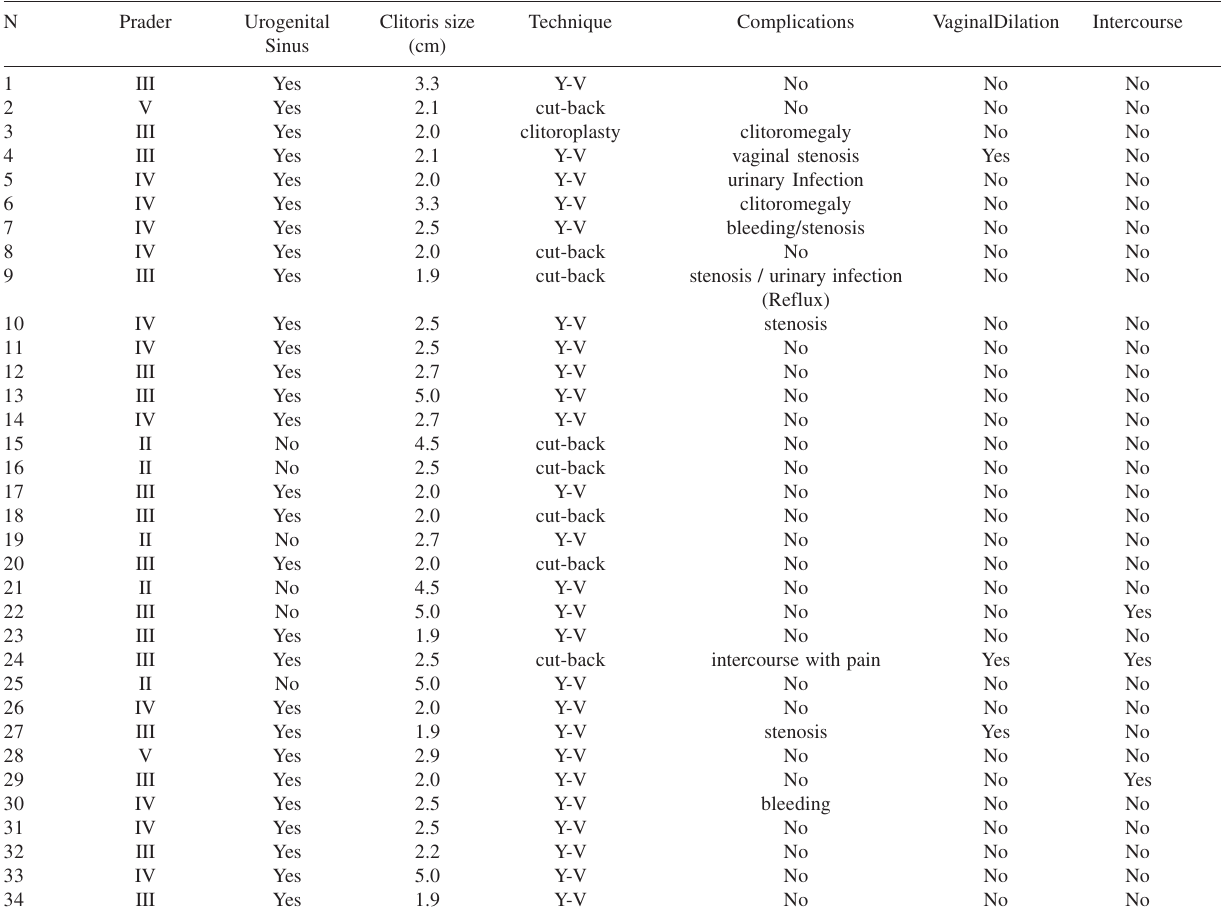
Table 1 - Grade of virilization of external genitalia, surgical technique and results of patients undergoing feminizing